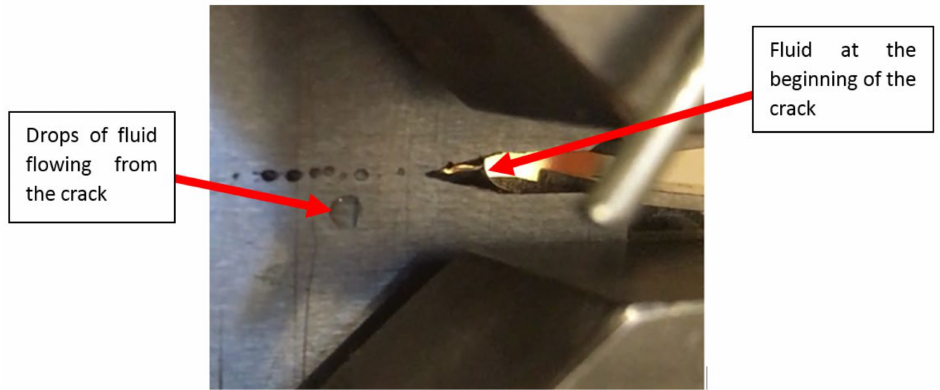
Figure 6. Specimen with fluid injected into the machined notch tip of CT specimen mounted in the hydraulic pulsator.